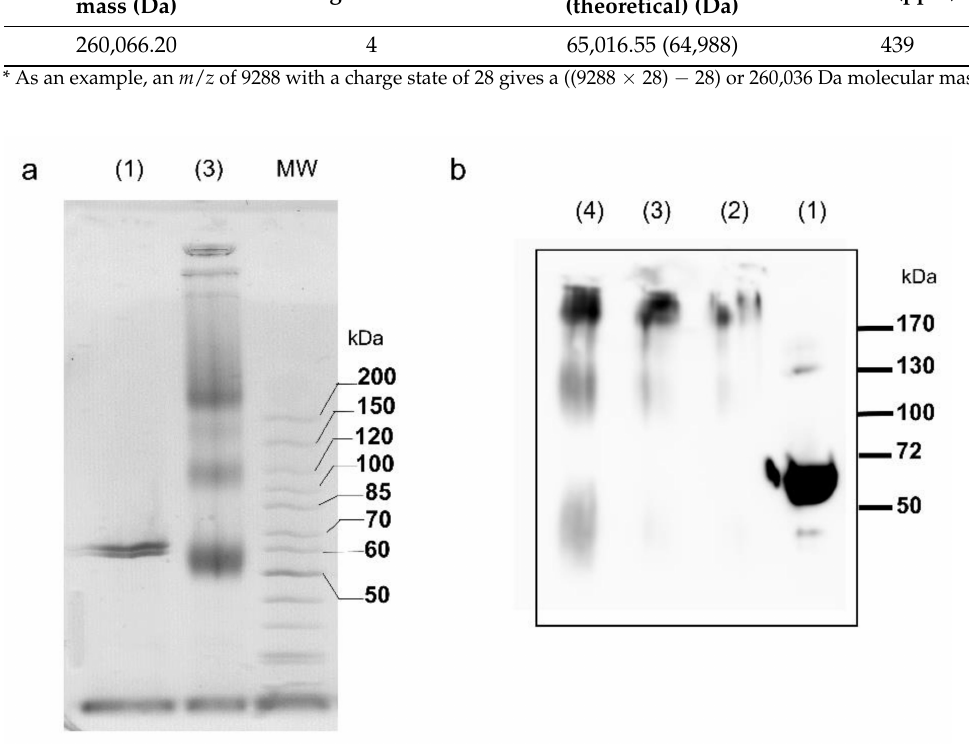
Figure 2. Glutaraldehyde-induced protein cross-linking. ( a ) SDS-PAGE and ( b ) Western blot of